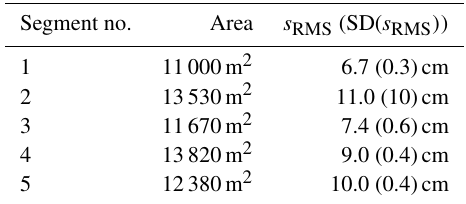
Table 3. Estimated sea ice surface roughness ( s RMS ) from five seg- ments at the floe by R/V Lance . Values in parentheses display stan- dard deviations (SD) of s RMS